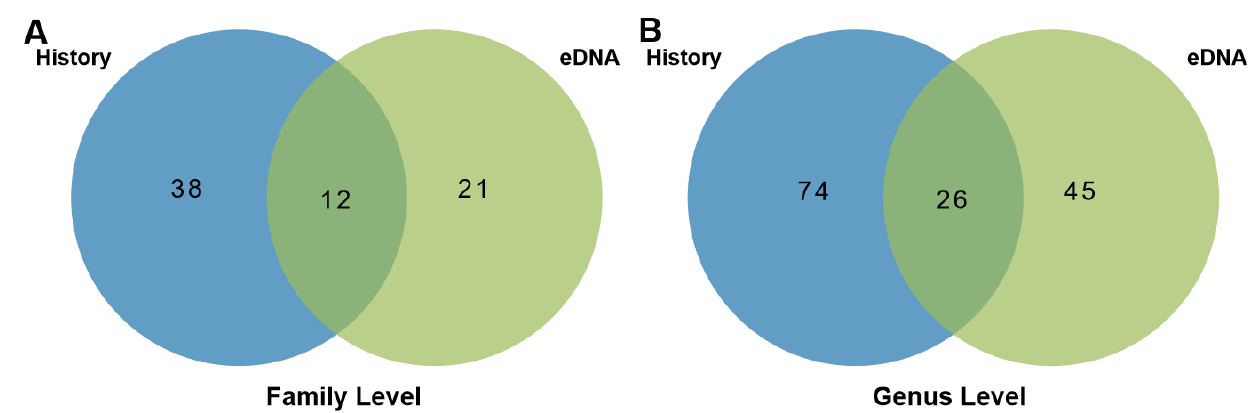
Figure 2. Paired comparison of the eDNA monitoring datasets and the historical records at the family ( A ) and genus ( B ) levels in the Dongjiang River.